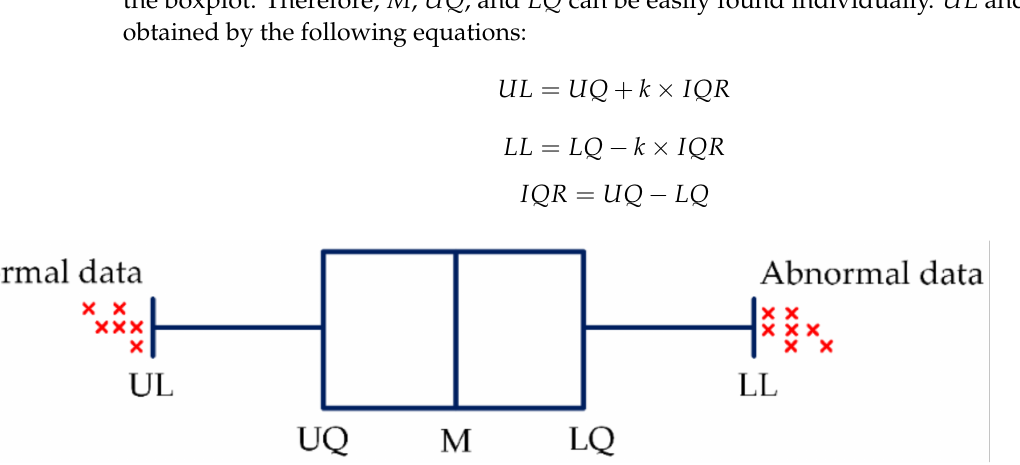
Figure 2. Schematic diagram of the working principle of box-plot